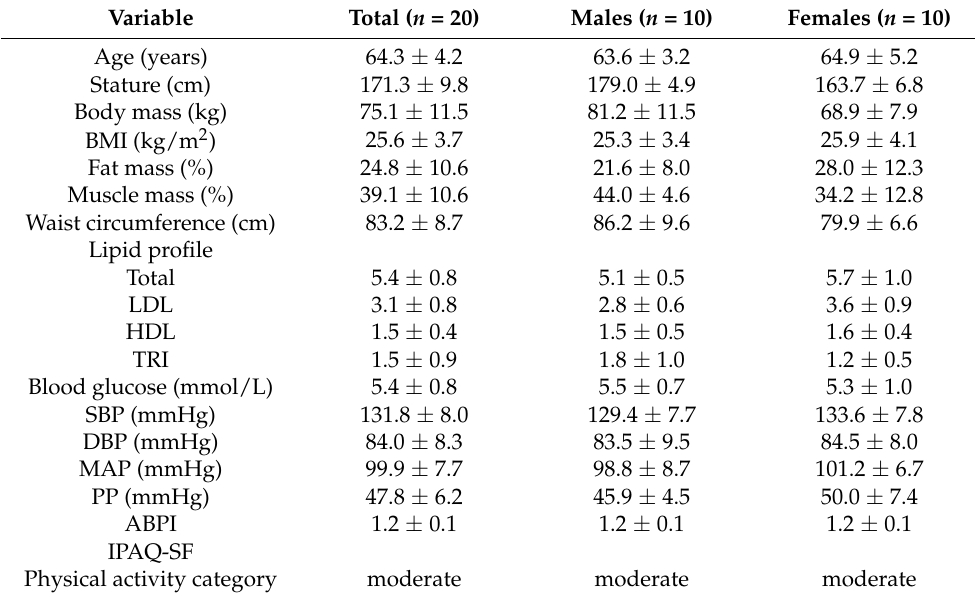
Table 1. Participants baseline